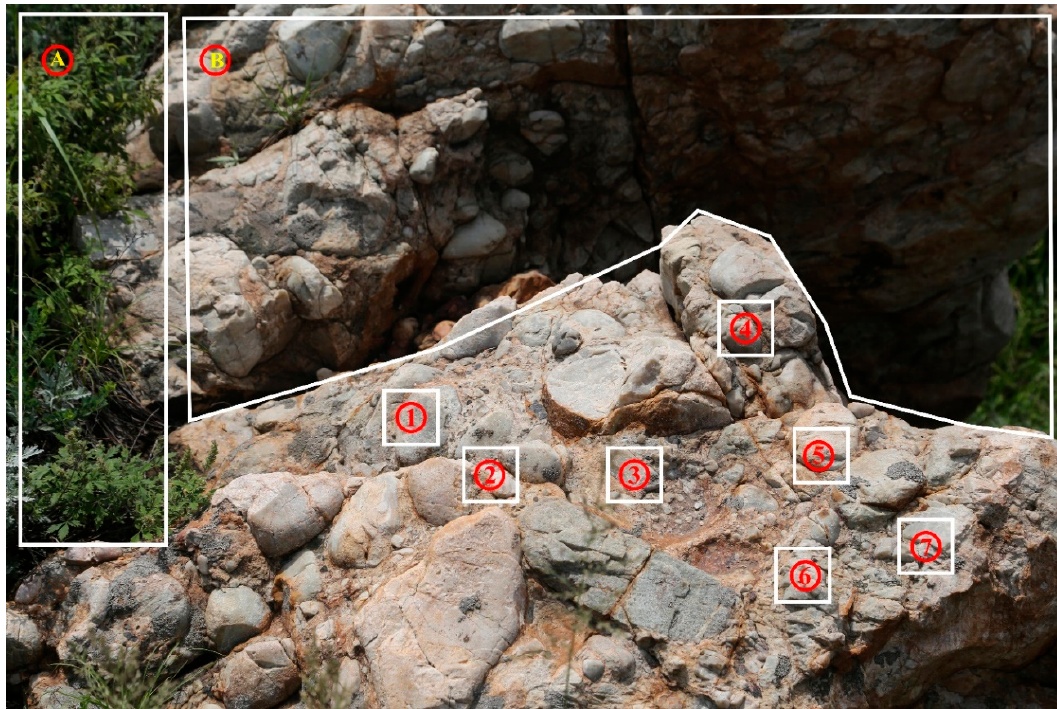
Figure 6. The extraction of typical rock samples from high-resolution images. Two or more image samples (512 × 512 pixels) are cropped from an original field rock image of 5760 × 3840 pixels. Area A is identified as vegetation cover, and area B is out of focus. Boxes 1–7 are manually labeled as sample patch images. Table 3. Datasets for image classification of field